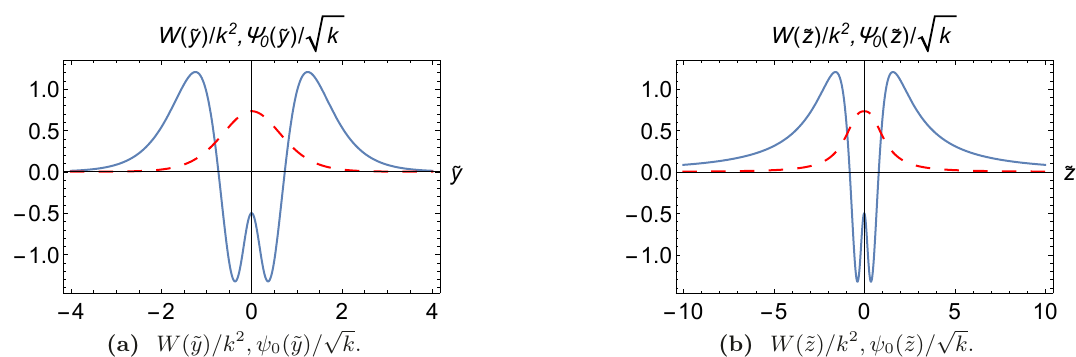
Figure 4. Plots of W (˜ y ) /k 2 and W (˜ z ) /k 2 (the blue solid lines), and plots of ψ 0 (˜ y ) / √ k and ψ 0 (˜ z ) / √ k (the red long-dashed lines), where W (˜ y ) and W (˜ z ) are the effective potentials in eqs. (6.1) and (3.20) , and ψ 0 (˜ y ) and ψ 0 (˜ z ) are the zero mode of the graviton in eqs. (5.4) and (5.1) , respec- tively. Here ˜ e = 2, and ˜ g = 1 40